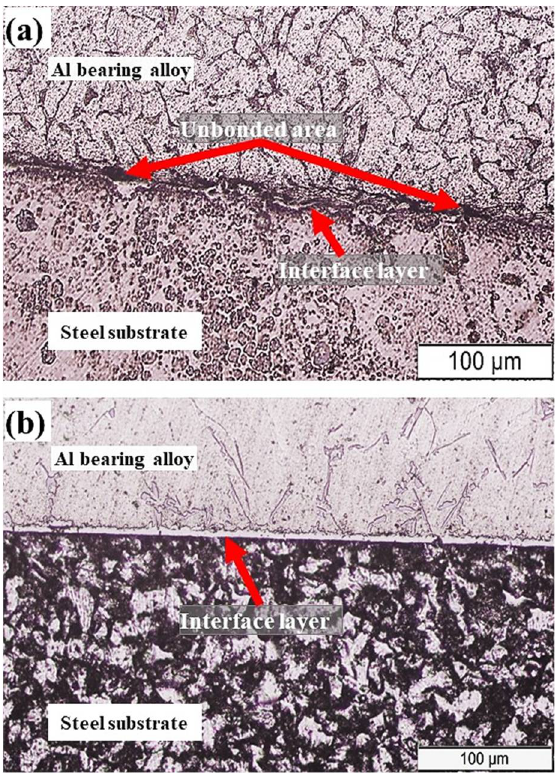
Figure 4. OM image of bimetal composites: ( a ) bimetal A and ( b ) bimetal B.